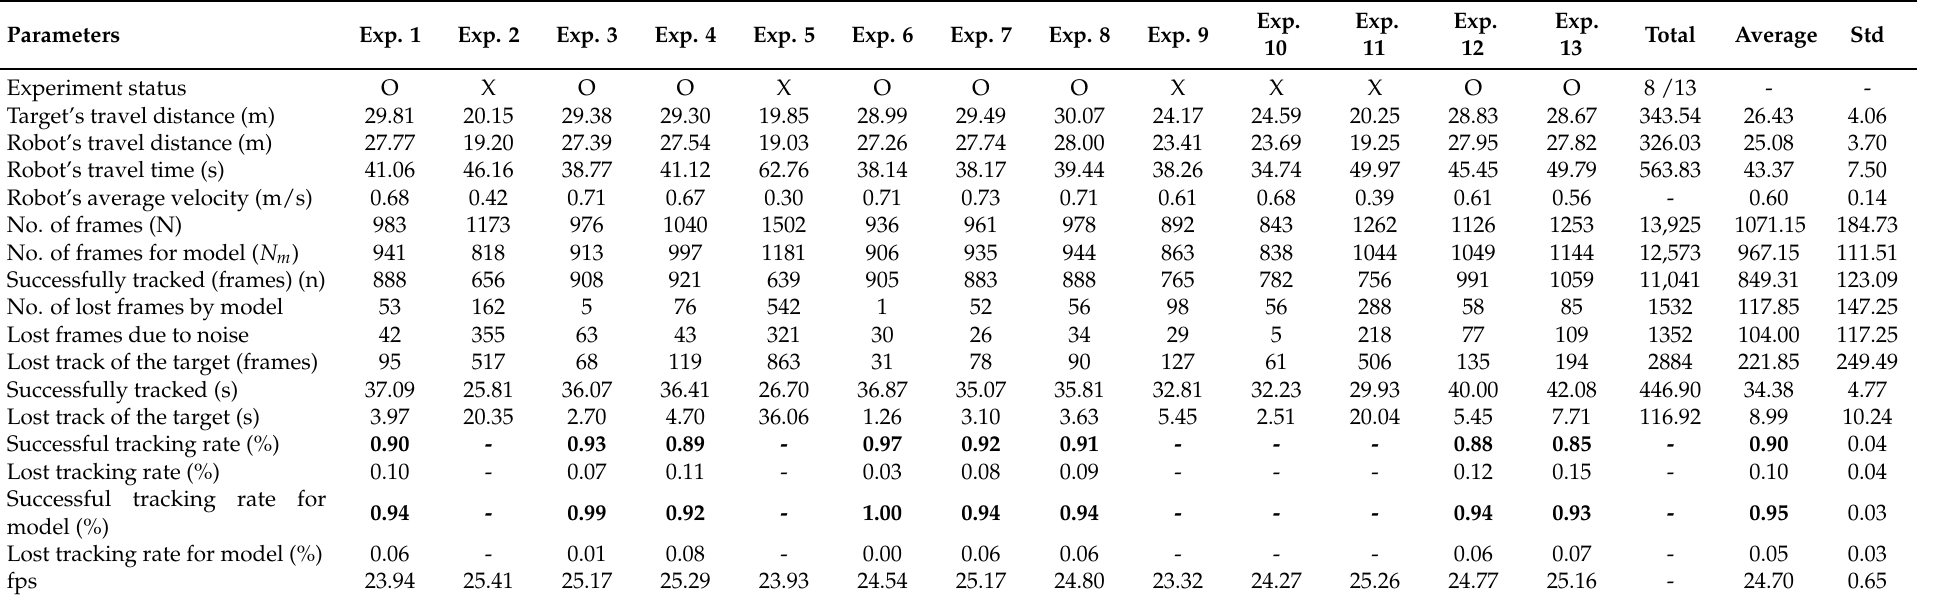
Table 5. Experimental results using only two features for the black